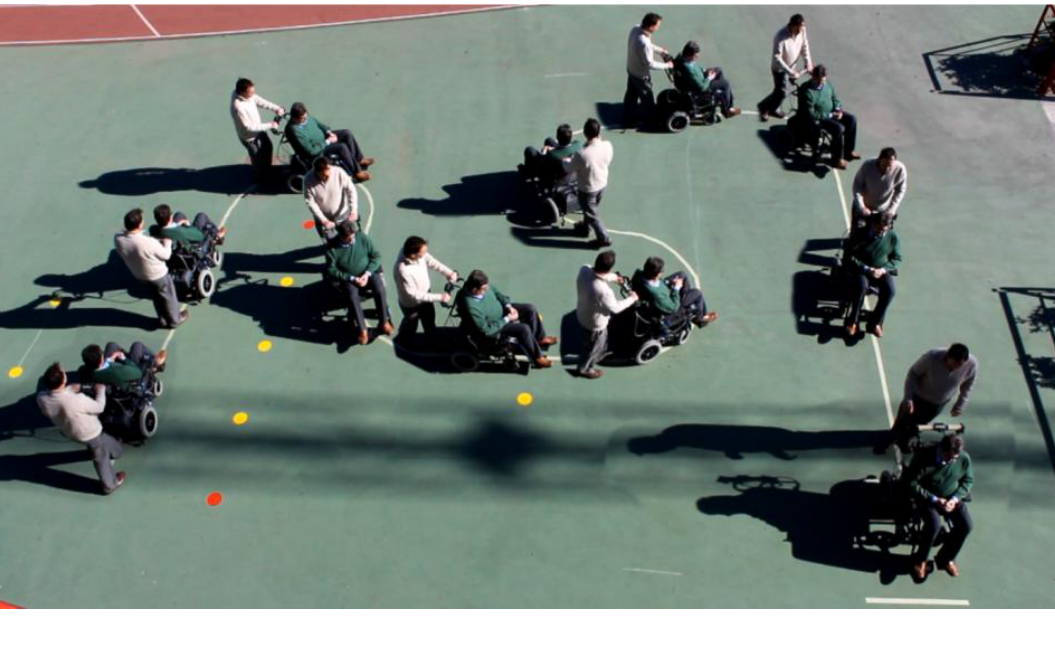
Figure 21. Test path: second user.